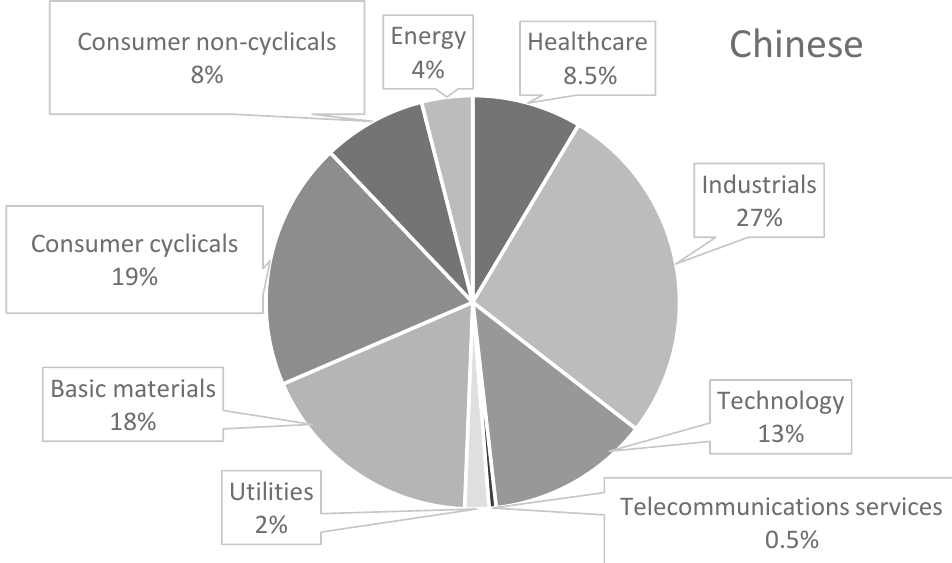
Figure 1b. Industrial affiliation of